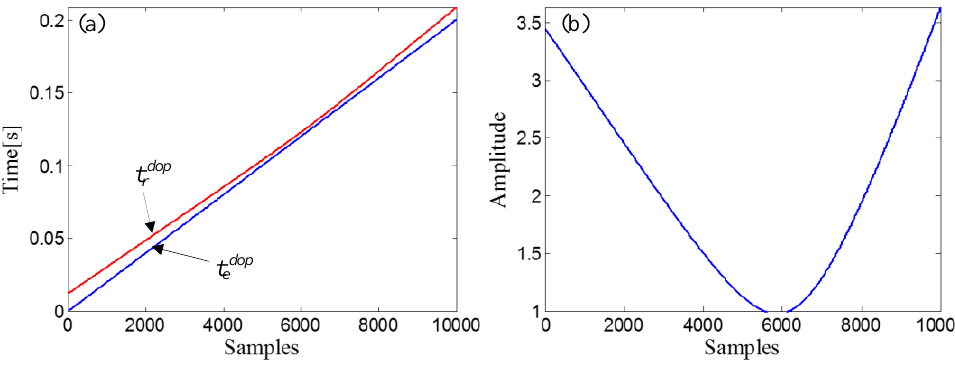
Figure 12. ( a ) Receive-time-vector (red curve) and the emit-time-vector (blue curve) in the simulation case; ( b ) Curve of the demodulation weights in the simulation case.